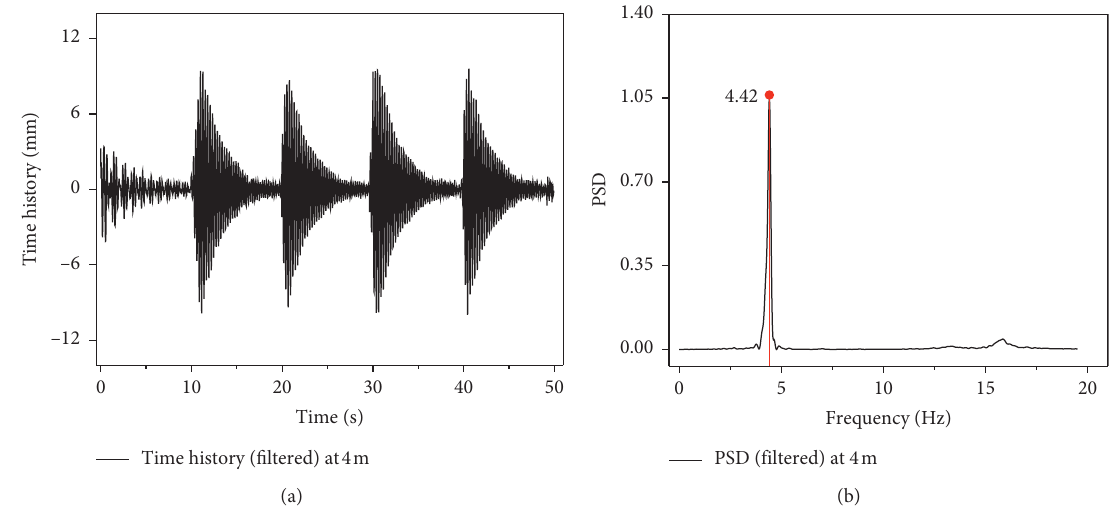
Figure 7: Filtered DIC data at node 15. (a) Time history at 4m. (b) PSD at 4m.